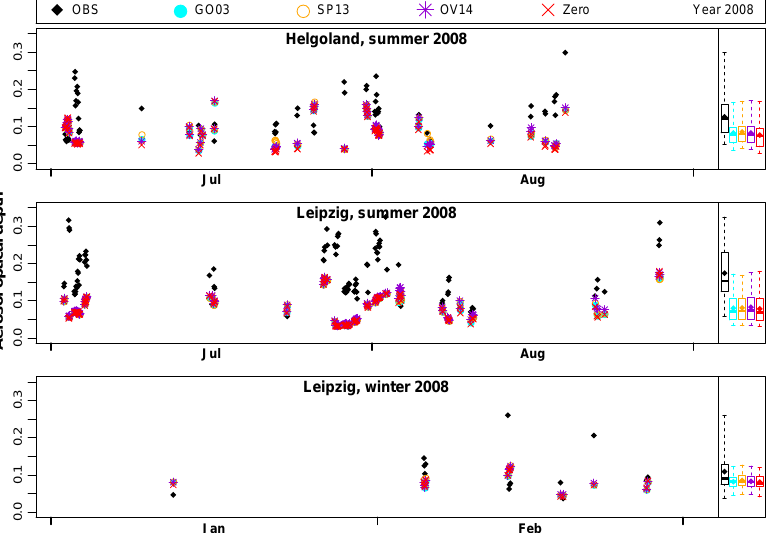
Figure 13. Aerosol optical depth (AOD) at the two stations Helgoland (top row) and Leipzig (center and bottom rows). The Helgoland data are only available for summer 2008 and the Leipzig data for summer (center) and winter 2008 (bottom). AODs of measurements (black symbols) and of the four model cases (colored symbols) are plotted. Data points are only plotted if valid model and measurement data are